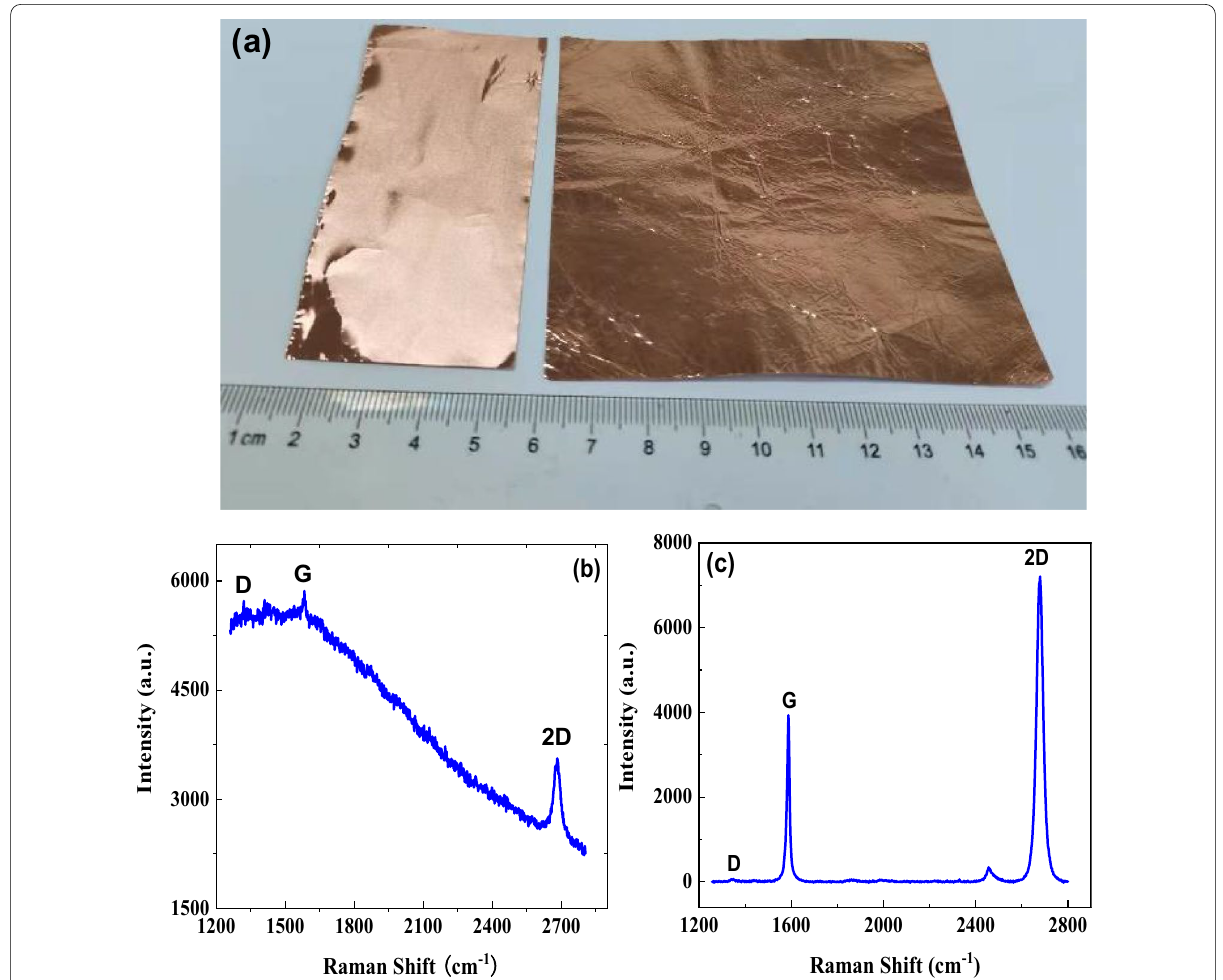
Fig. 1 a Photograph of bare Cu foil (left panel) and graphene grown on Cu foil (right panel), b Raman spectrum of graphene/Cu, and c Raman spectrum of graphene/SiO 2